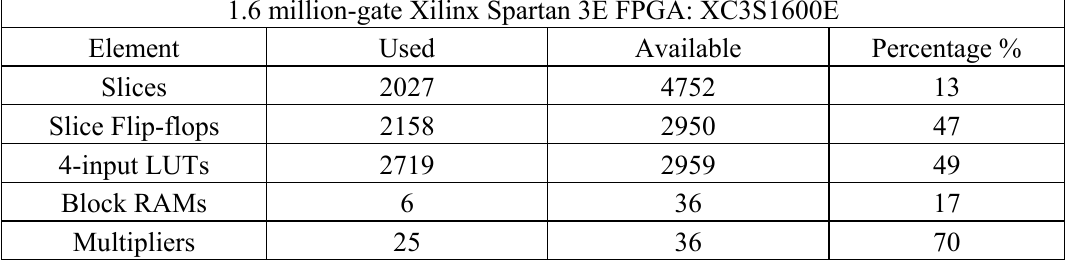
Table 1. FPGA resource